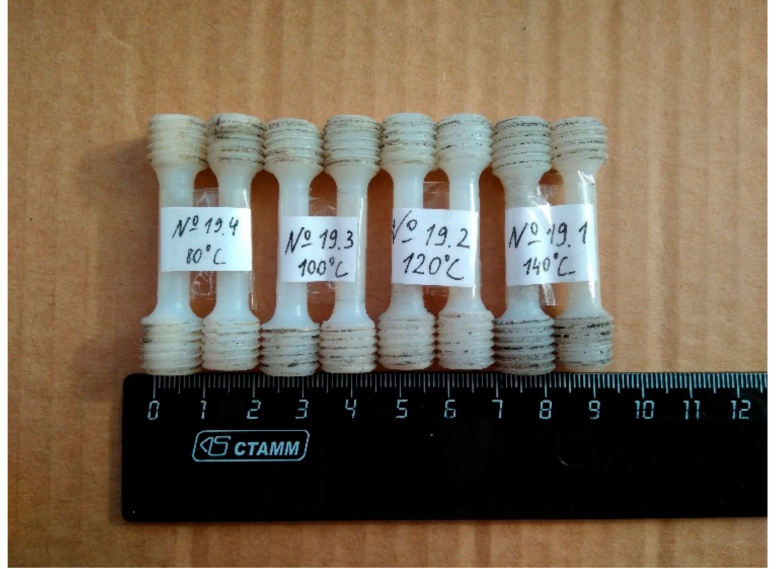
Figure 3. Tensile test samples made from compacts produced by CIC at preheating temperatures of 80, 100, 120 and 140 ◦